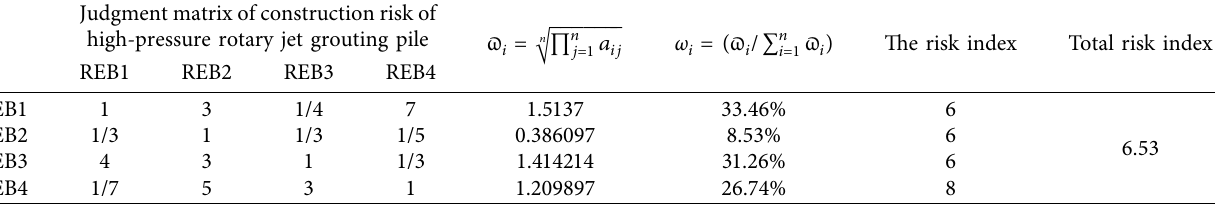
Table 20: Judgment matrix of construction risk of high-pressure rotary jet grouting pile.